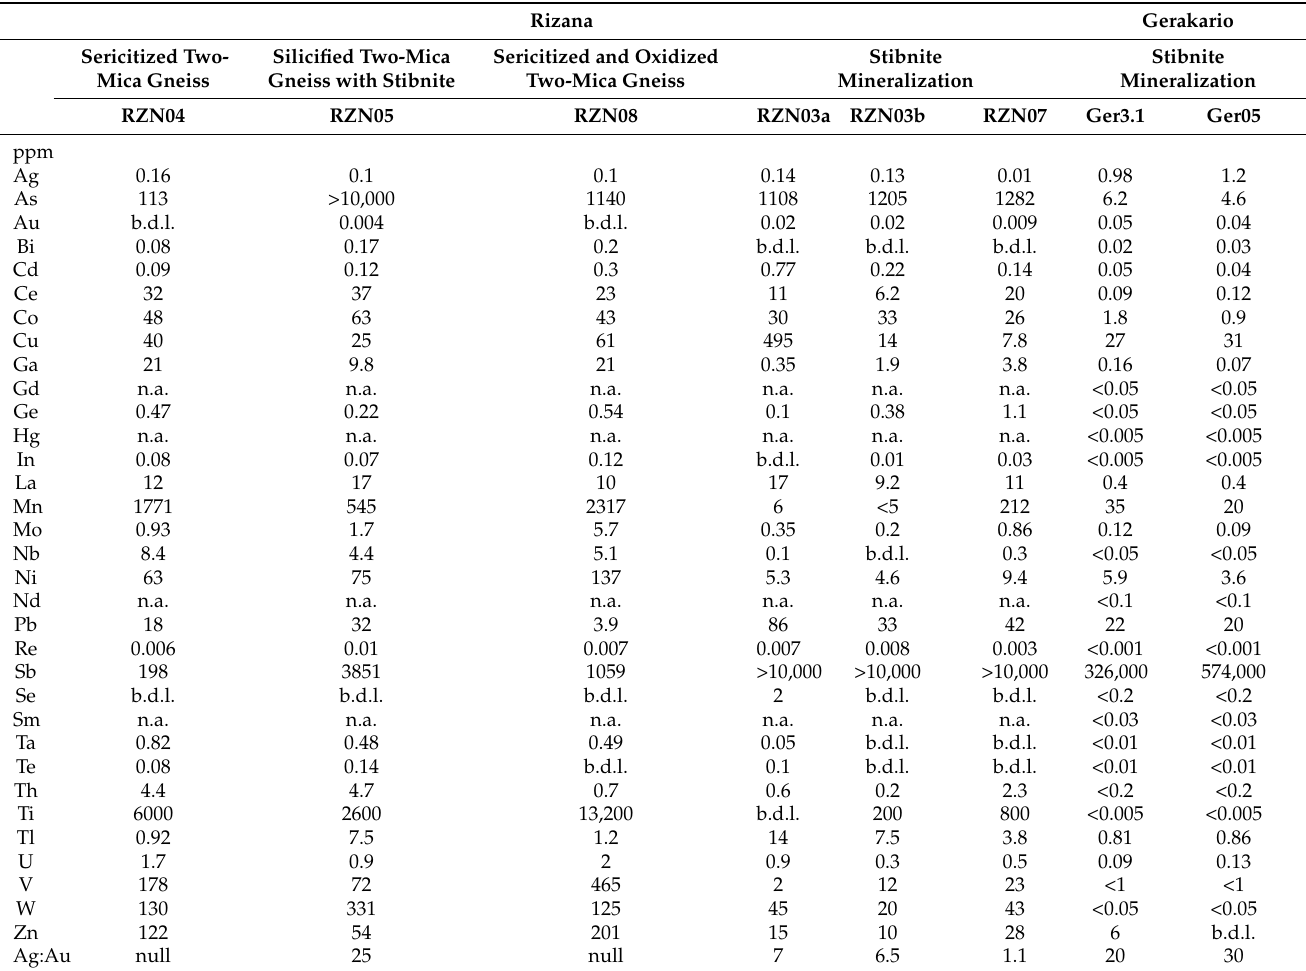
Table 4. Bulk ore geochemical analyses of selected base and critical metals from the Rizana and Gerakario stibnite mineralization [8]. Please see Table S1 in the Supplementary Materials for the full geochemical